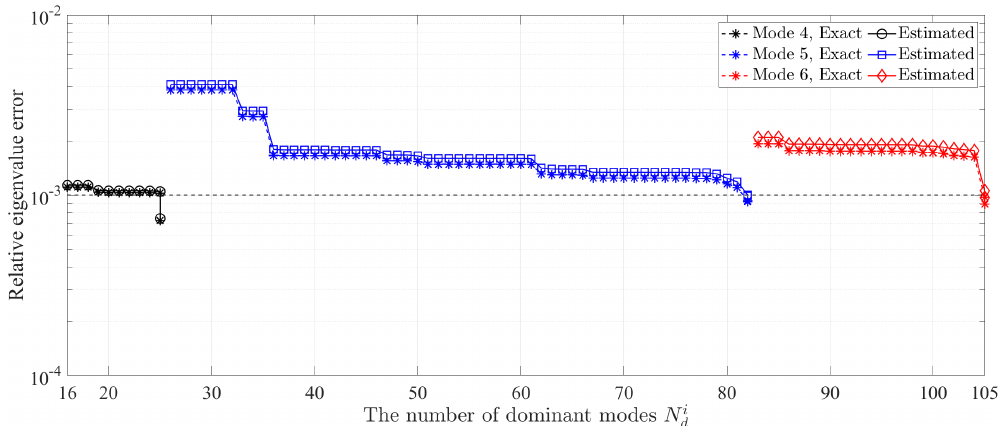
Figure 14. The changes of the relative eigenvalue error and its estimation with respect to the number of dominant modes for the specific modes. The error tolerance e i and the mode range N i m are 0.1% and 10, respectively.